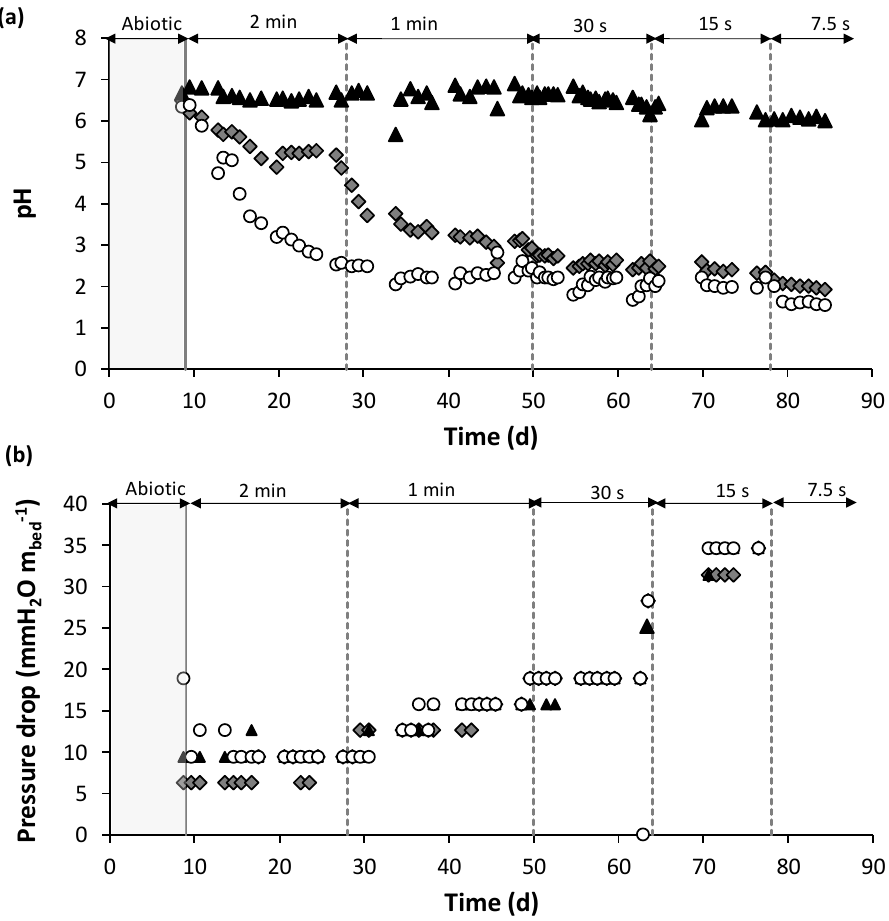
Figure 3. Time course of ( a ) pH and ( b ) pressure drop in the BTF-F ( (cid:7) ), the BTF-FAC ( (cid:78) ) and the BTF-K ( ). Vertical dashed lines delimit different stages.